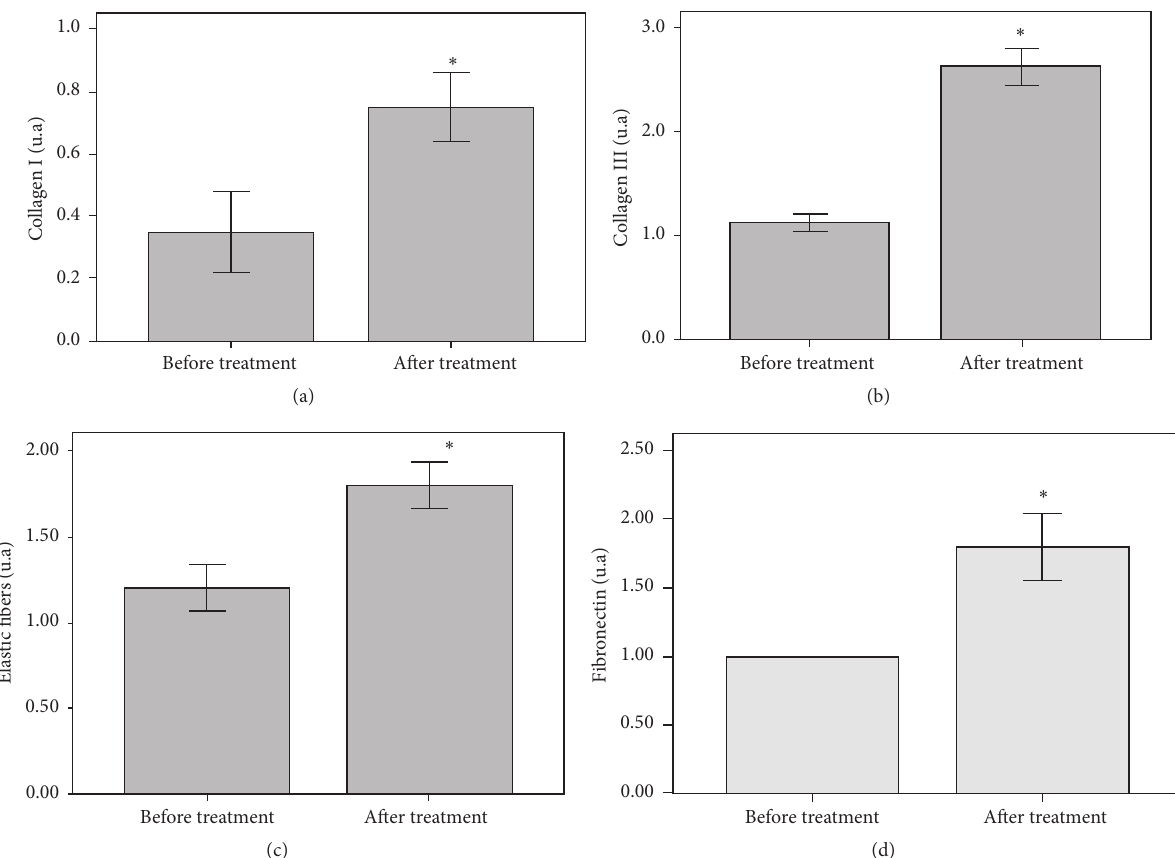
Figure 5: Semiquantitative analysis of immunohistochemistry images of collagens I (a) and III (b), elastin (c), and fibronectin (d) before and after the cosmetic treatment, showing increases of 50.0%, 100.0%, 116.6%, and 80.0%, respectively, in the levels of each ECM component at the end of the treatment compared to baseline ( ∗ 𝑝 ≤ 0.05